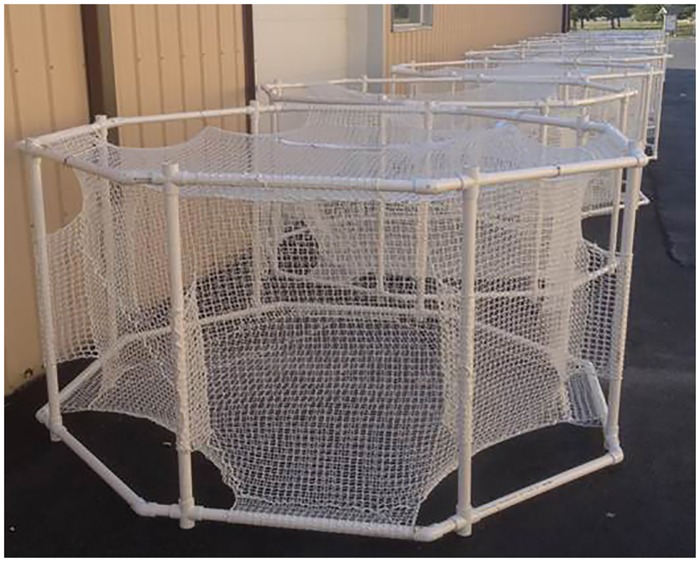
Fish exposure cages.